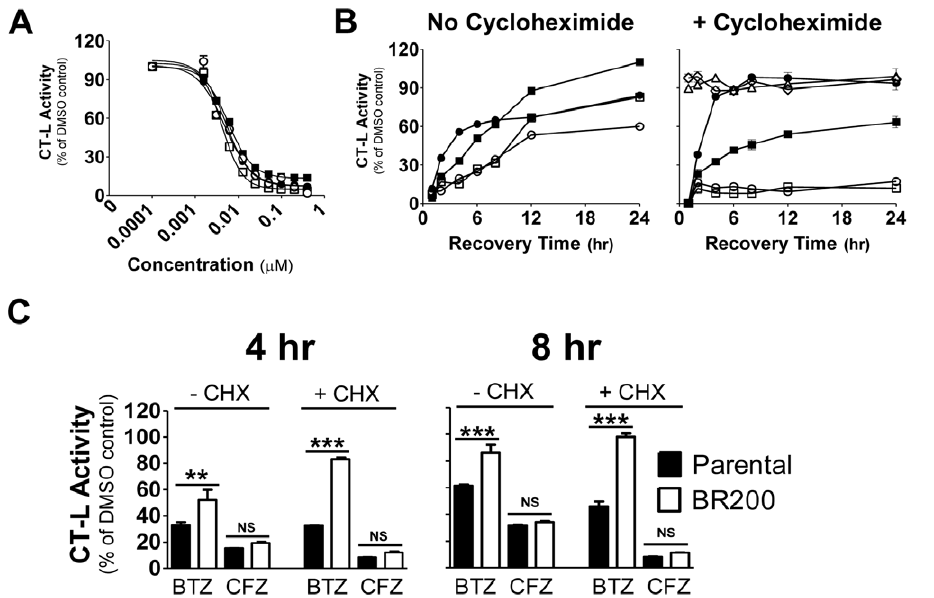
N , # ) were cultured for 3 days